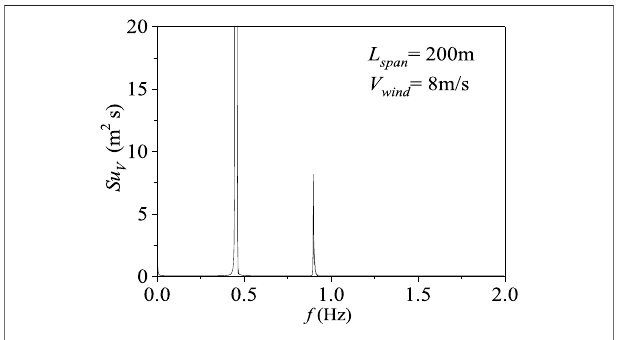
FIGURE 4 | Displacement spectrum analysis of the midpoint displacement of the subconductor of the fi rst span of the iced eight-bundle conductor of 200 m span length.